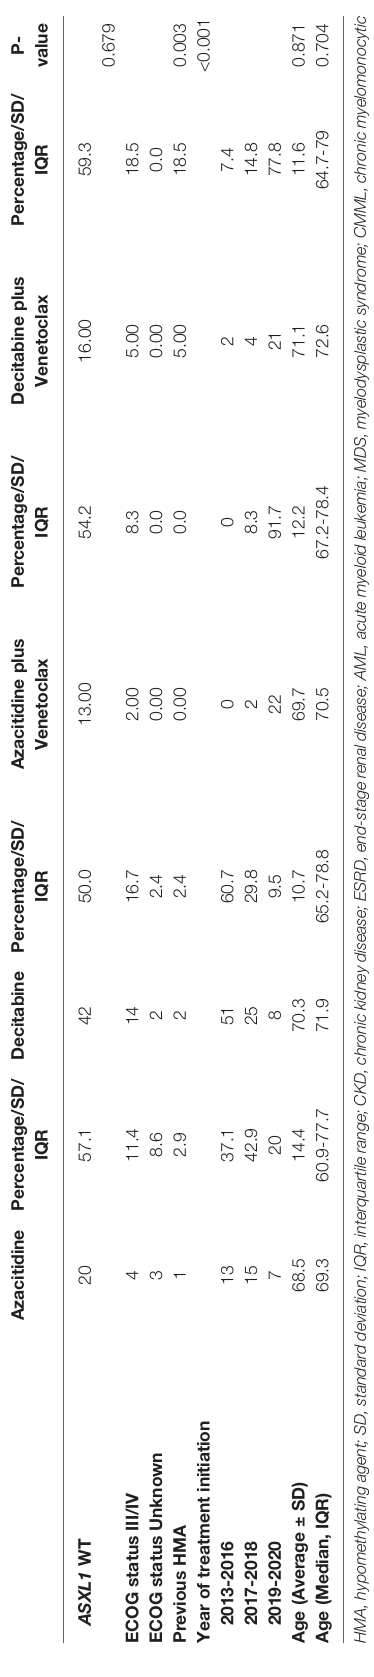
Baseline Characteristics and